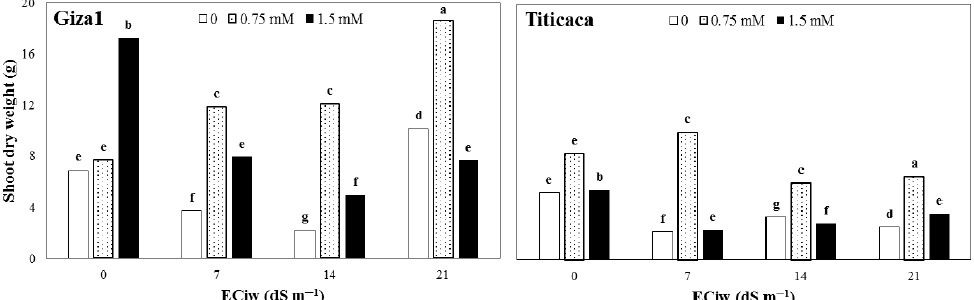
Figure 1. Shoot dry weight of two quinoa cultivars treated by varied salicylic acid concentrations grown under different salinity of irrigation water (ECiw). The columns with at least a similar letter in each figure are not significantly different based on LSD at 1% probability level.